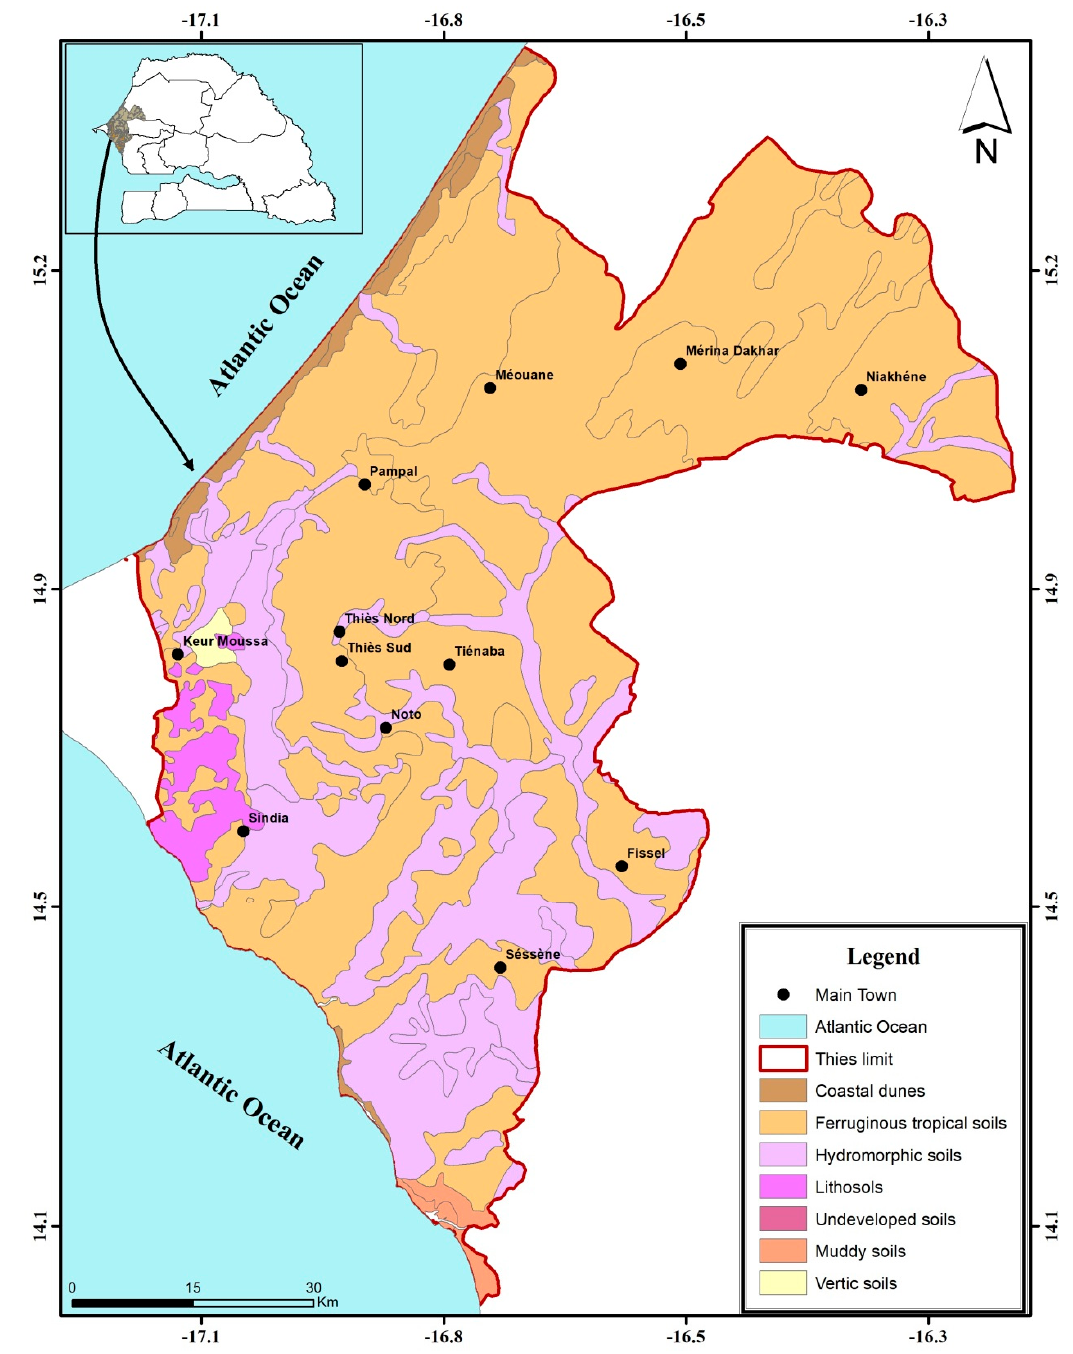
Figure 1. Localization of the study area and distribution of the different soil types [34]